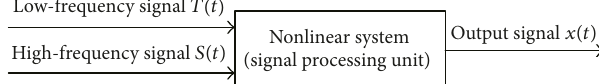
Figure 1: Simple block diagram of